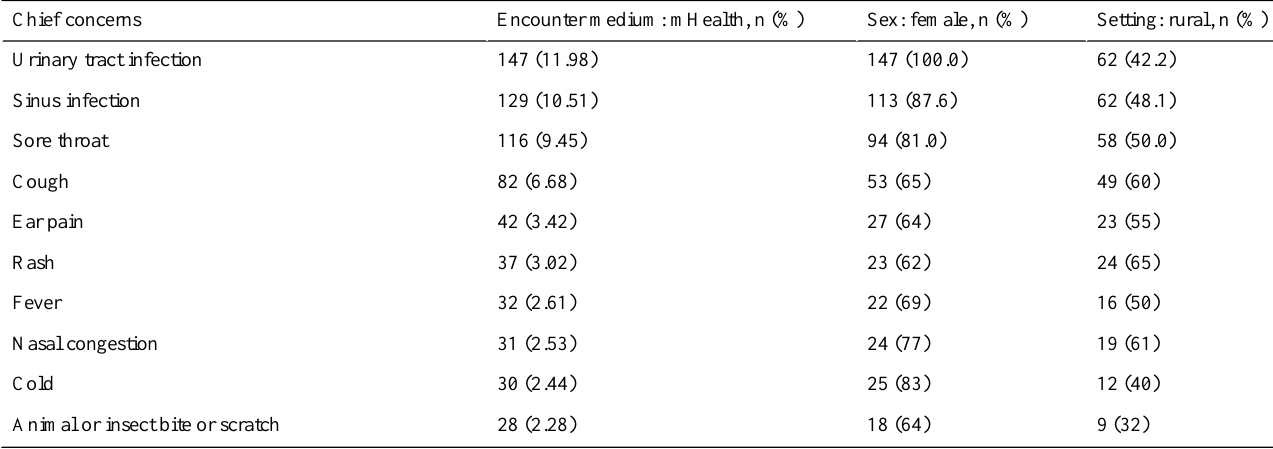
Table 5. Top 10 chief concerns in mobile health (mHealth) encounters